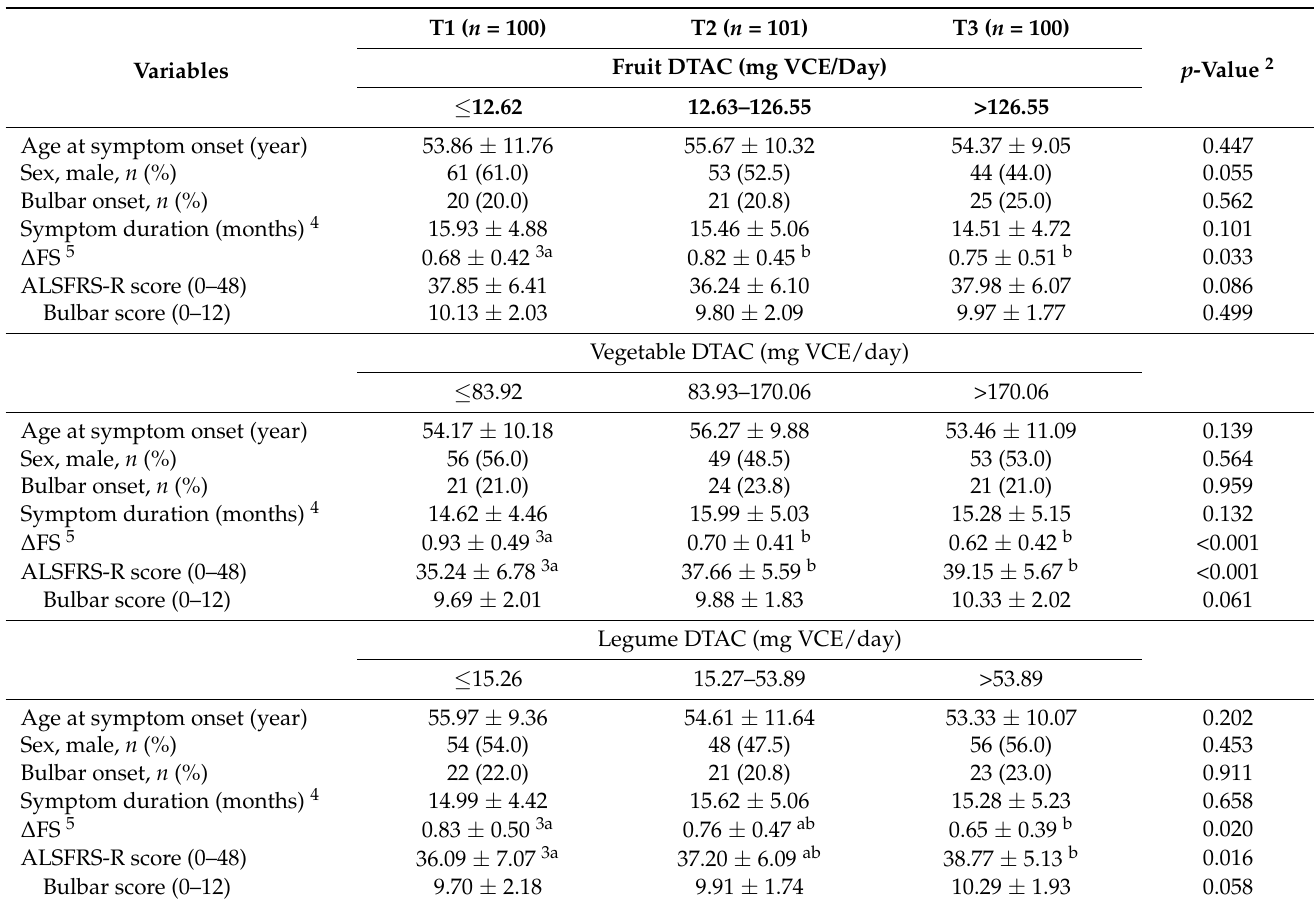
Table 2. Demographics and clinical features of the participants according to tertiles of the dietary total antioxidant capacity (DTAC) of major food groups 1